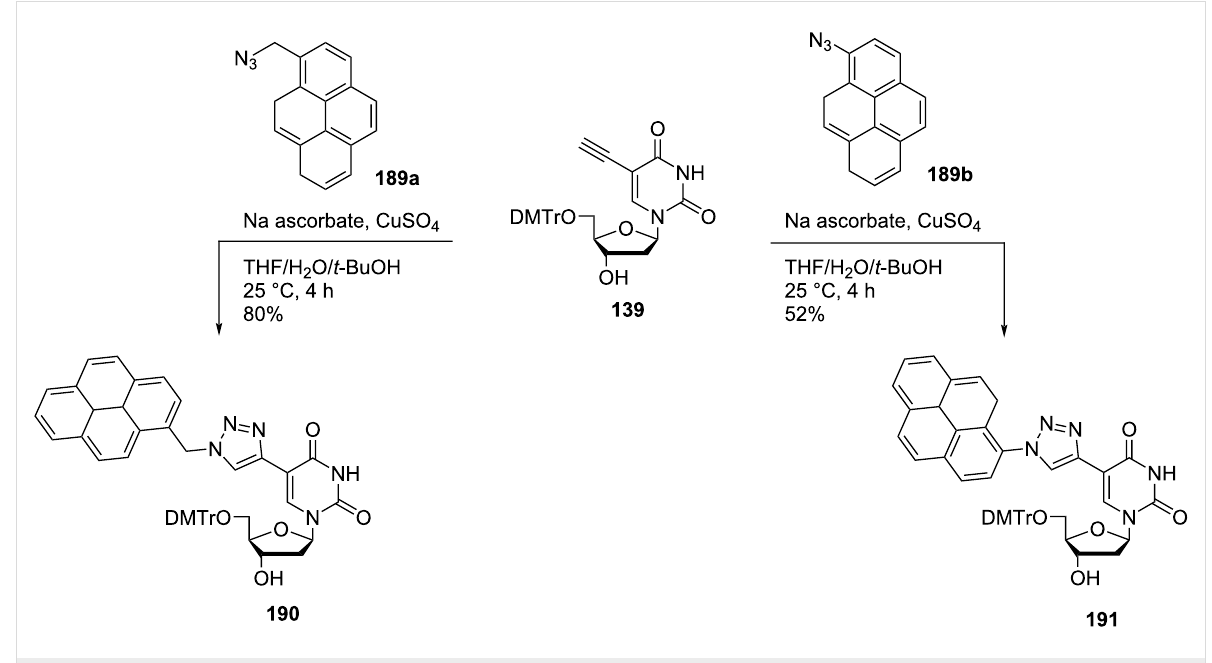
Scheme 50: Synthesis of the double-headed nucleosides 190 and 191